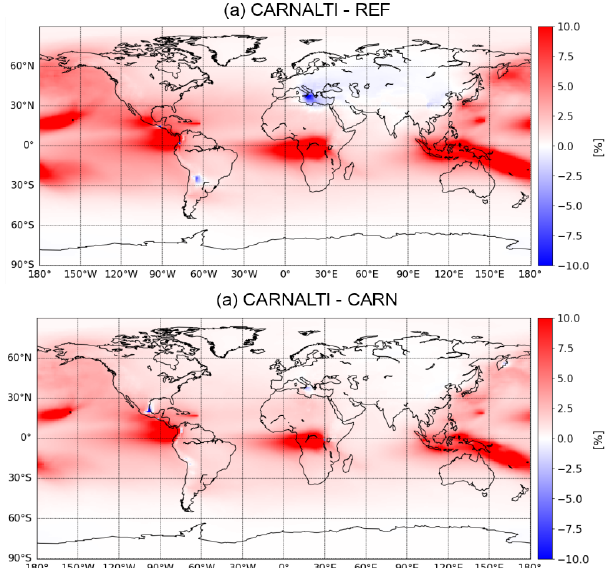
Figure 7. The 2013 annual mean sulfate tropospheric column rel- ative difference between the (a) CARNALTI and REF simulations and the (b) CARNALTI and CARN simulations (in